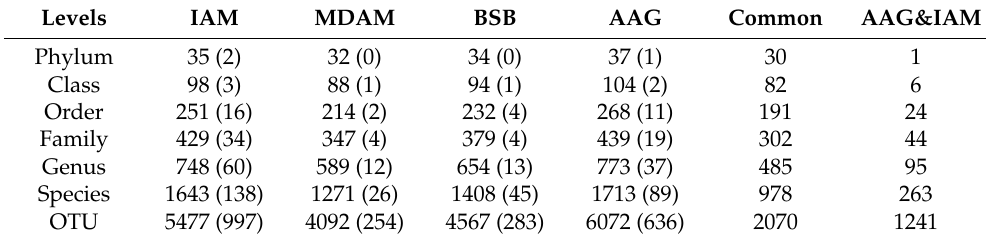
Table 2. Distribution of total bacteria, unique, and common in different groups.